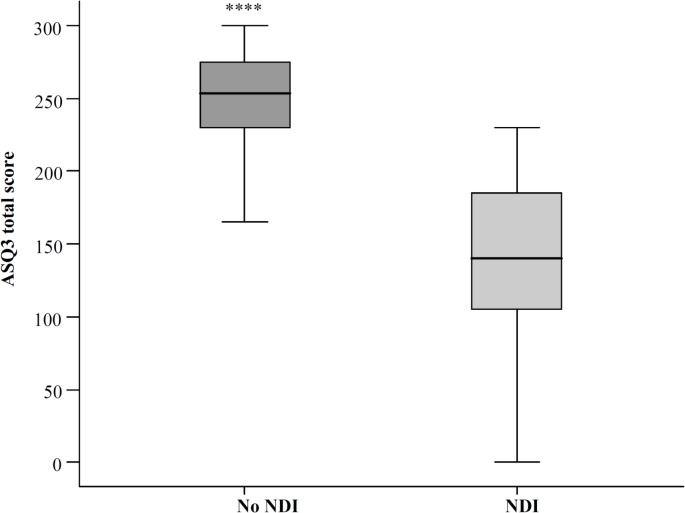
ASQ3 total scores for children with No NDI and children with NDI.NDI with BSID threshold set at < 70. Incomplete BSIDIII scores due to CP or severe mental impairment were imputed at 50 and incomplete ASQ3 scores were imputed with 0 points per item without a valid score.**** p< 0.0001